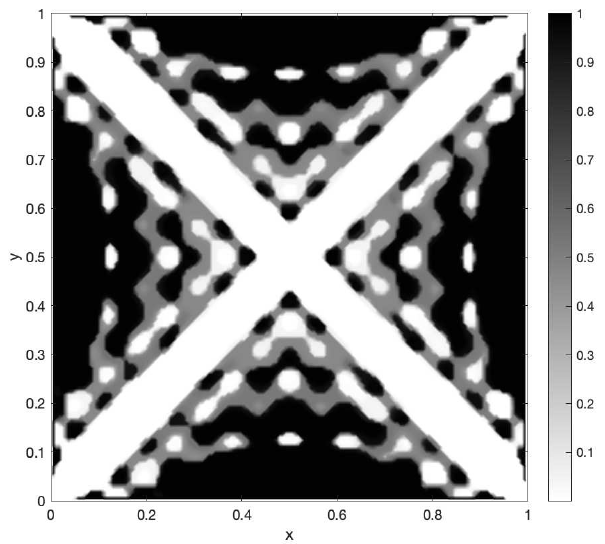
Figure 7. Approximated optimal Figure 7: Approximated Optimal Control